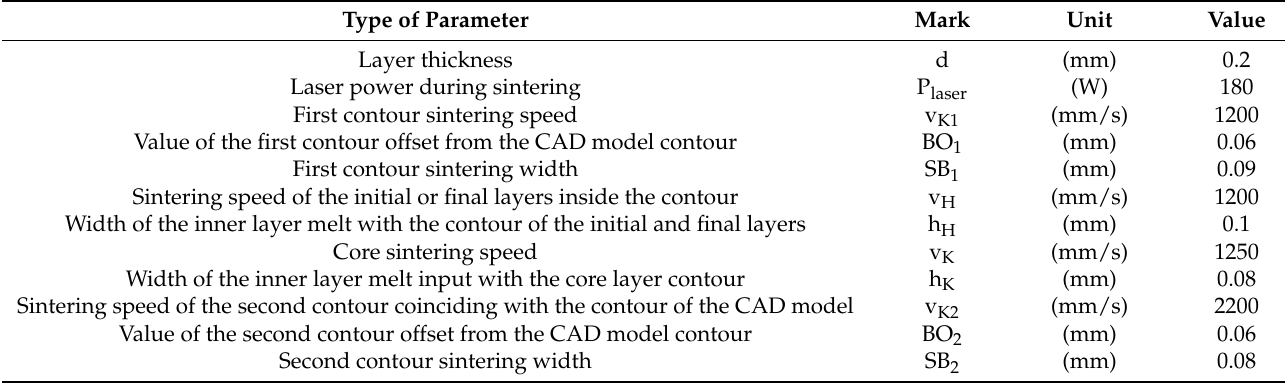
Table 5. Selected parameters of the sintering process in the DMLS method.